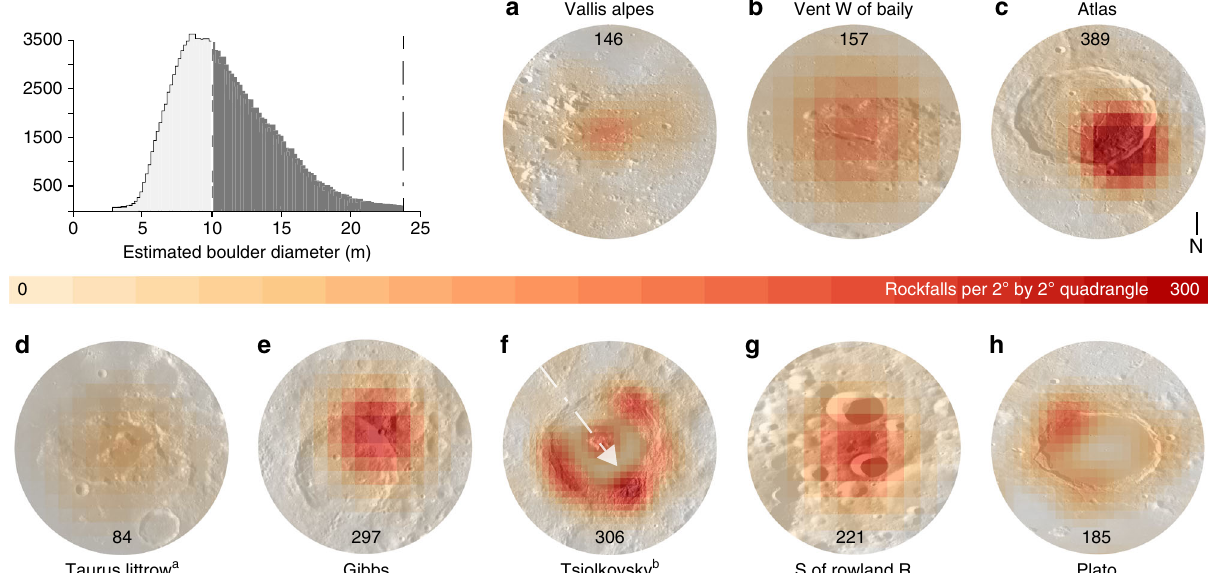
Fig. 2 General rockfall diameter distribution and details of Fig. 1. The histogram shows the general distribution of estimated rockfall diameters. Estimated rockfall diameters are based on the output of the neural network and are potentially biased for smaller diameters (section indicated in white), as the CNN ’ s detection accuracy is reduced when detecting small features. Insets a – h are details from Fig. 1 and represent graben ( a ), pyroclastic vents ( b ), craters ( c , f , h ), regular slopes ( d ), and recent impacts ( e , g ). Some craters show a heterogeneous distribution of rockfall abundance, such as c , f , h . The peak count of spatial rockfall density is shown in the insets per 2° by 2° quadrangle. In e , g , we identi fi ed a series of rockfalls that are directly induced by small-scale impact events (impact-ejected); for details refer to Supplementary Fig. 2. a Apollo 17 landing site, b Morse et al. 30 proposed an impact trajectory for f based on the distribution of the ejecta blanket (axis NW – SE), which agrees with the rockfall distribution (white arrow). Global WAC mosaic in the background 40